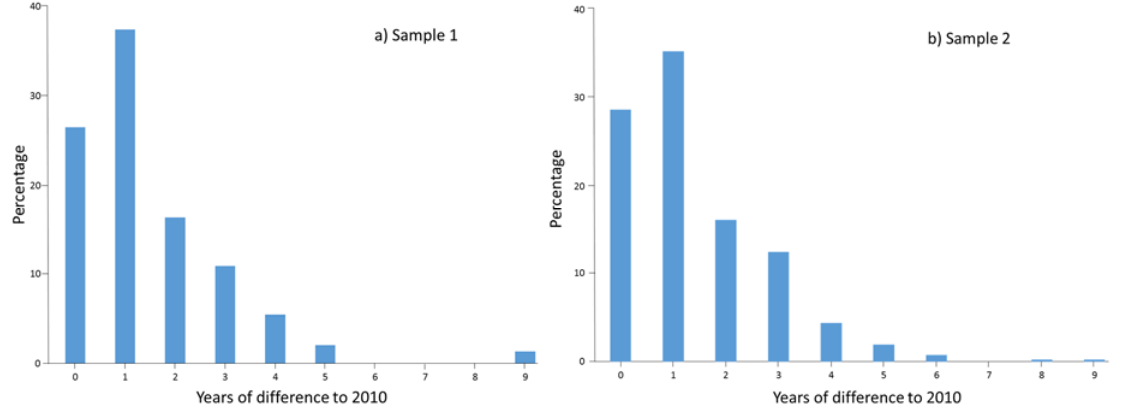
Figure 9. Distribution of the difference in years between the reference year for GlobeLand30 (2010) and the available high resolution imagery in: ( a ) Sample 1 ( n = 147); and ( b ) Sample 2 ( n = 411).